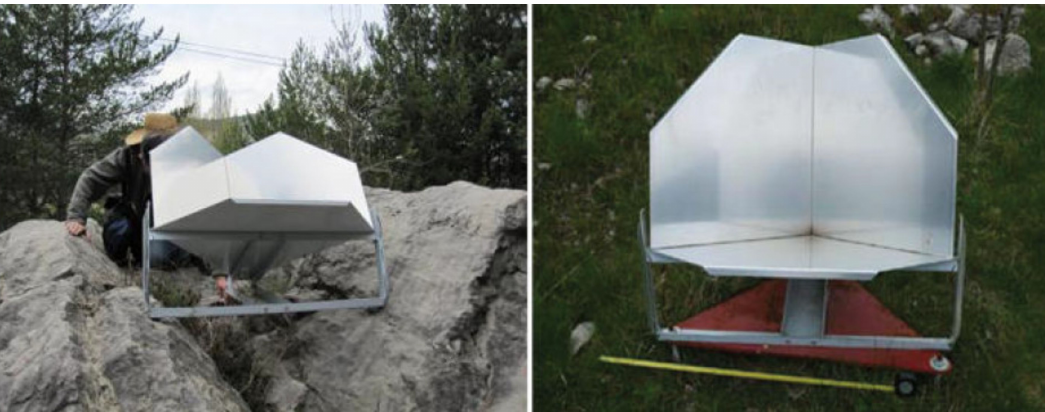
Figure 15. Corner Reflectors (CRs) used for DInSAR monitoring at the Vallcebre landslide [6]. Examples of installation on a big rock block ( left ) or directly over the terrain ( right